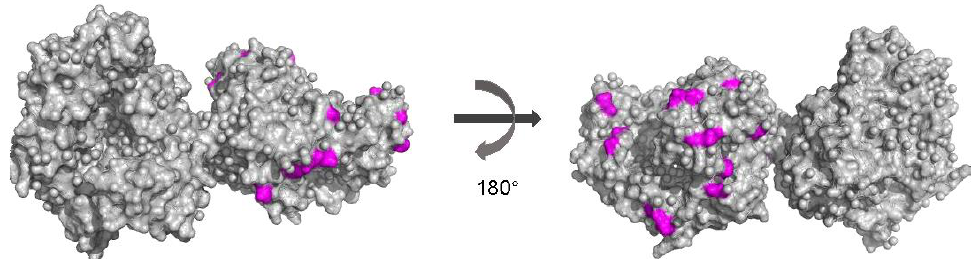
Figure 4. Mapping of positively selected and high-variable sites (colored in light magenta) on the structural model of norovirus GI RdRp protein (PDB number: 1SH0).